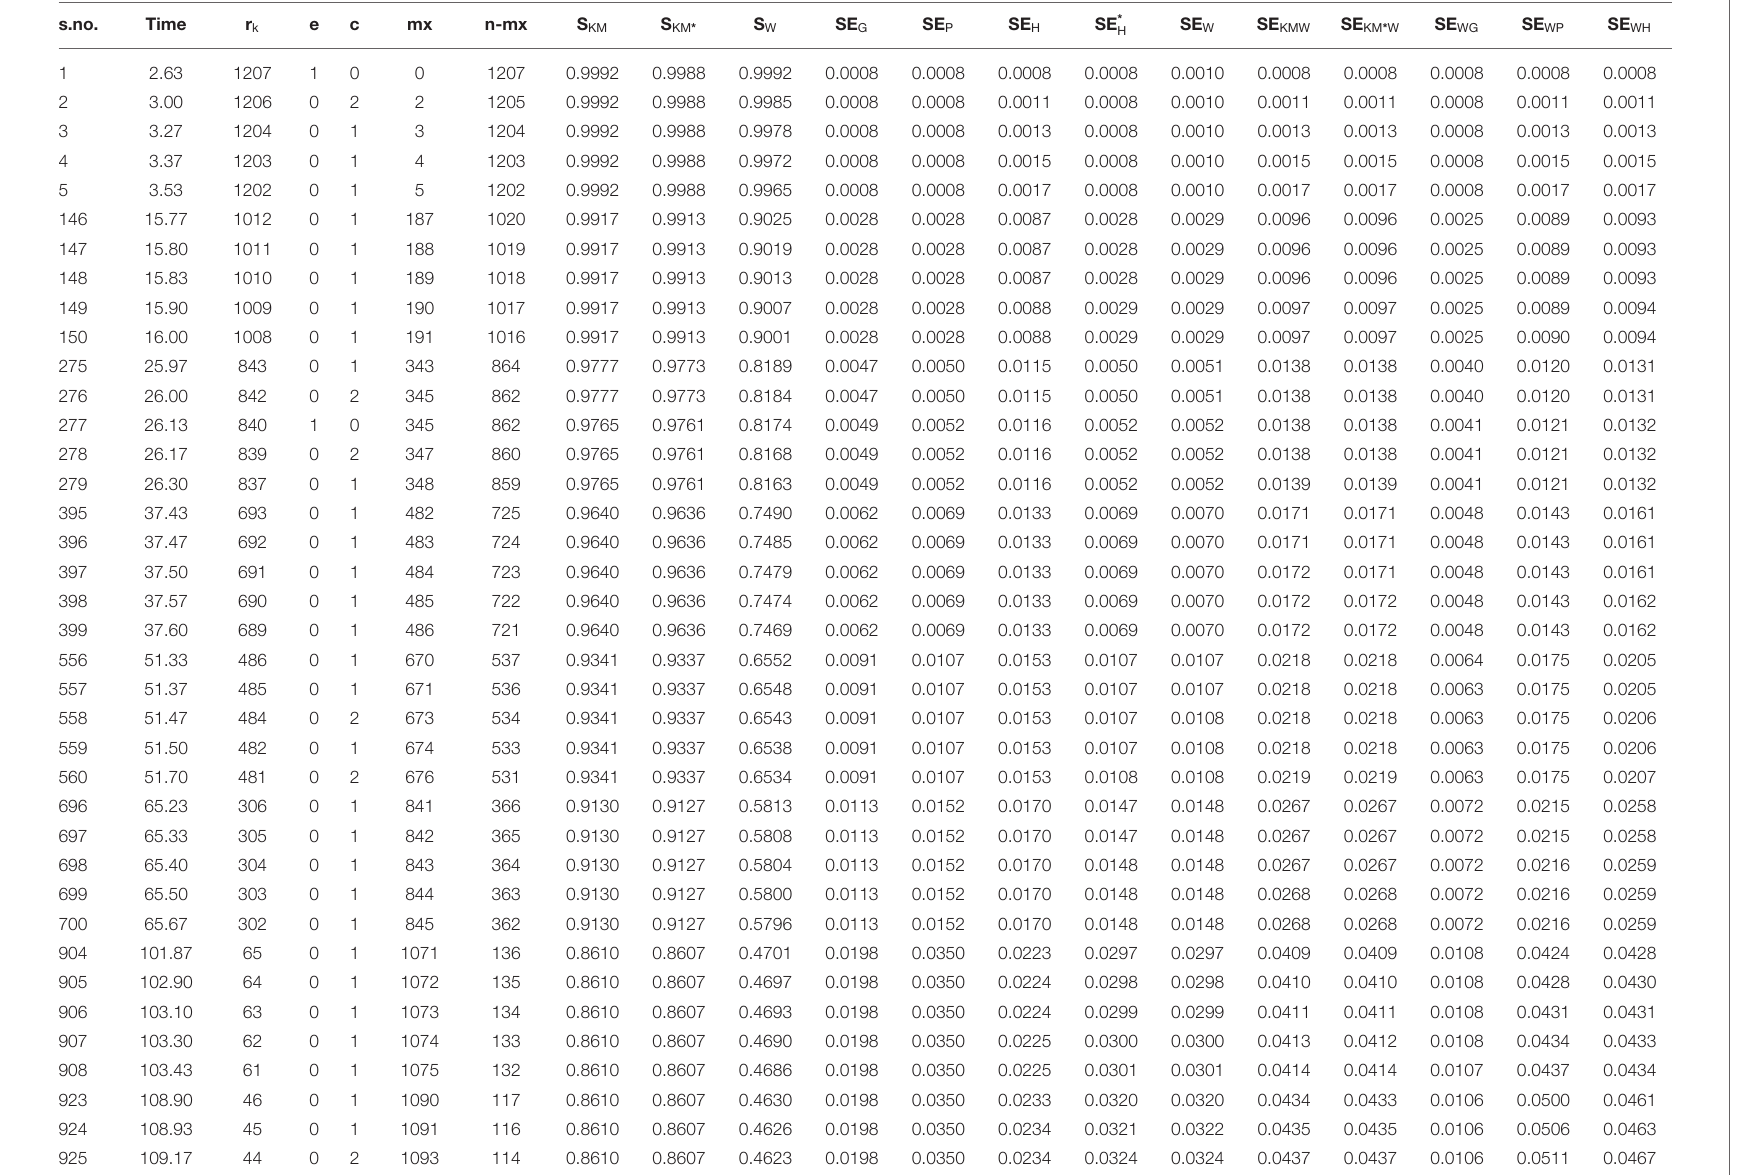
TABLE 5 | Selected estimated survival functions and SEs of the cancer data.